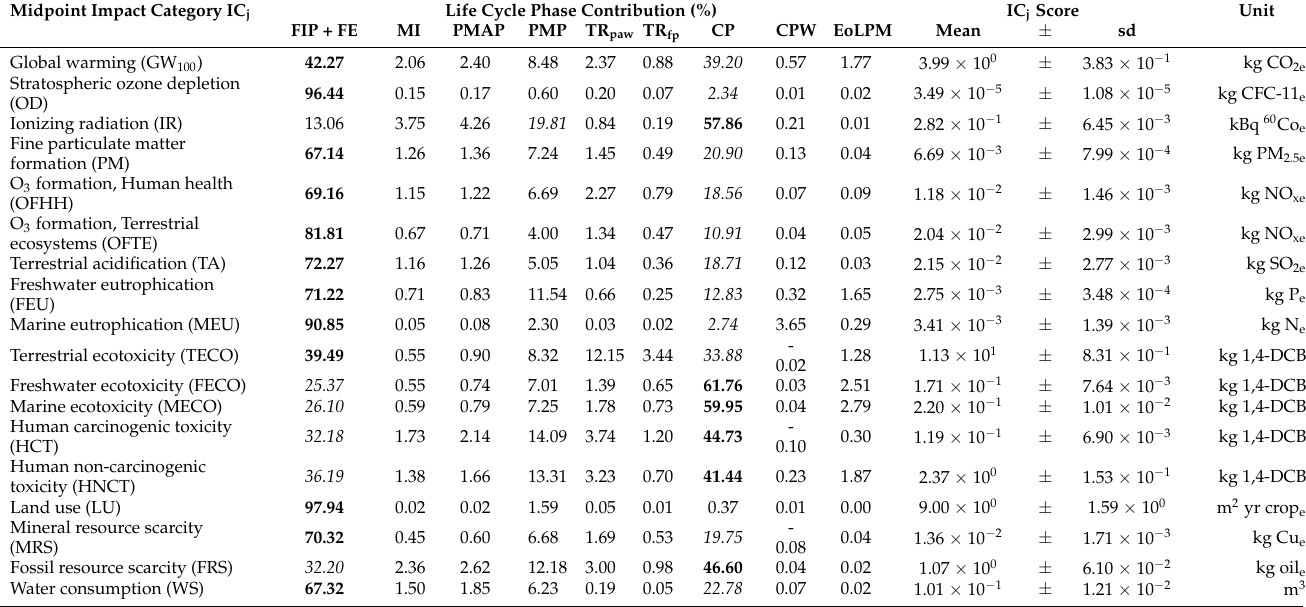
Table 7. Environmental profile of 1 kg of low-GI fresh pasta packed in 0.5-kg PE bags, as estimated using the ReCiPe 2016 standard method: Percentage contribution of the different life cycle phases (symbols as in Table 6), and overall score of each mid-point impact category